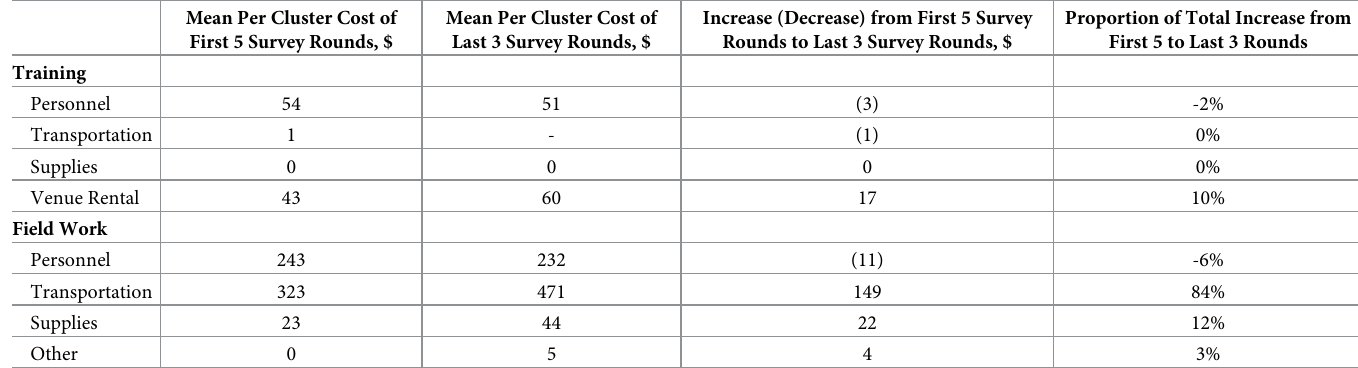
Table 5. Drivers of increased cost from the first 5 rounds to final 3 rounds of impact and surveillance surveys, Amhara, Ethiopia, 2012–2016. Mean Per Cluster Cost of First 5 Survey Rounds,